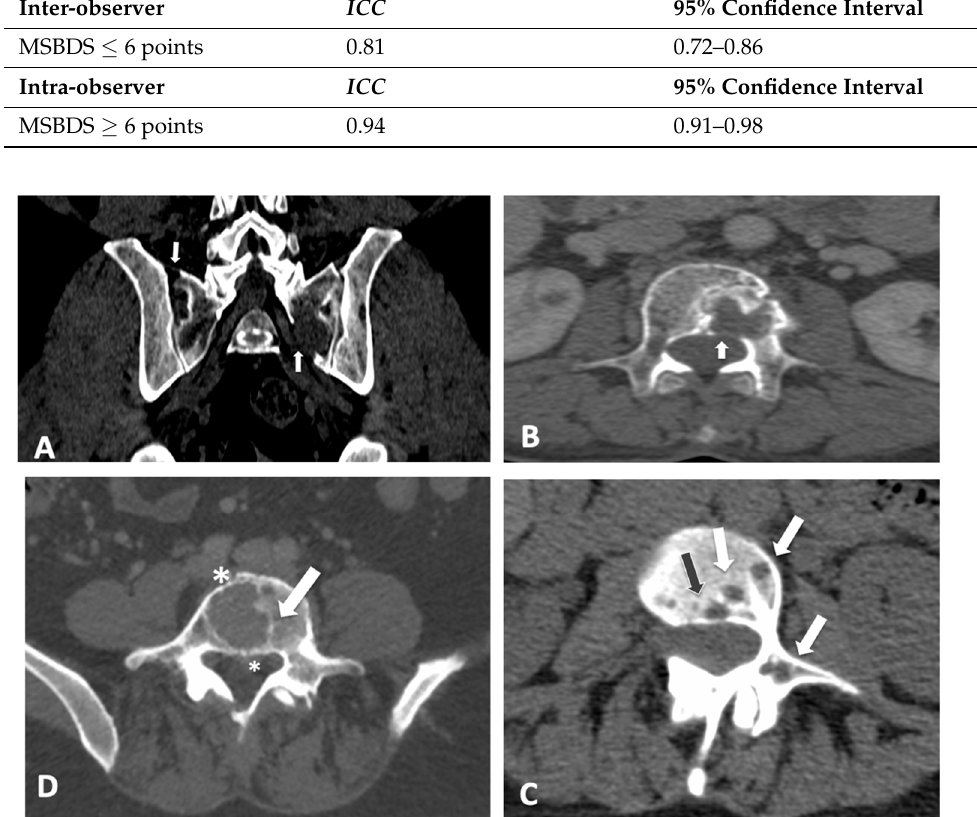
Figure 3. Scoring bone damage and instability: spectrum of findings with maximum disagreement among readers. Discrepancies with an MSBDS > 6. ( A ) Focal lytic lesions >5 mm in diameter located at the left sacrum (white arrow) with another small lesion in the sacrum near the sacroiliac joint. In this case, the MSBDS was 7 with a standard deviation of 4.9. ( B ) Single large focal lytic lesion >5 mm in the vertebral body (white arrow) with no vertebral collapse (sagittal not shown) but possible spinal canal infiltration. In this case, the MSBDS was 11 with a standard deviation of 5.3 due to difficulties in spinal canal assessment mainly by non-specialists. In these cases, a sub-specialized second reading should be recommended. Discrepancies with an MSBDS < 6. ( C ) Multiple lytic lesions >5 mm (white arrows and the black arrow) at the junctional spine (T11-L1 level) with involvement of the vertebral body and pedicle. In this case, the MSBDS was 4 with a standard deviation of 2.6. ( D ) Single large focal lytic lesion >5 mm in the vertebral body (white arrow) with no vertebral collapse. In this case, the MSBDS was 5.7 with a standard deviation of 3.3 due to difficulties in spinal canal assessment, bone diameter and extraosseous involvement (asterisks). Table 3. Global inter- and intra-observer agreement among the 15 readers considering the MSBDS with scores below or equal to 6 points and scores above 6 points. K values are reported as weighed with linear weights.